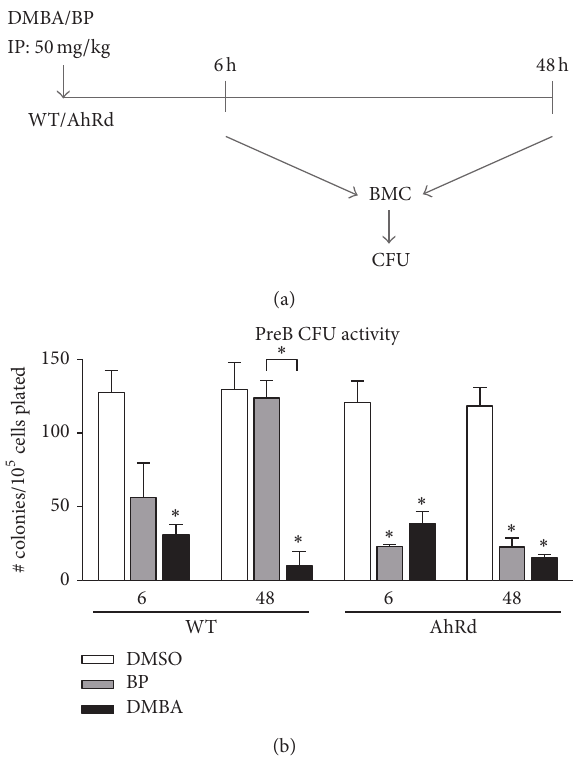
Figure 1: Comparison of progenitor activity after in vivo PAH treatment in mice with normal (WT) and diminished (AhR d ) AhR activity. (a) Diagram of in vivo treatments and isolation points for colony forming unit (CFU) analyses. Mice were treated with DMBA or BP (50 mg/kg) or an equivalent volume of solvent control (DMSO) via a single IP injection. Bone marrow cells (BMC) were isolated 6 and 48 hours after treatment and analyzed for PreB CFU activity. (b) Comparison of PreB CFU activity in WT and AhR d BMC 6 and 48 hours after PAH administration (50 mg/kg). Significance ( ∗ 𝑝 < 0.05 ) indicates PAH suppression from untreated control or between PAH treatments at the same time point within a genotype, as